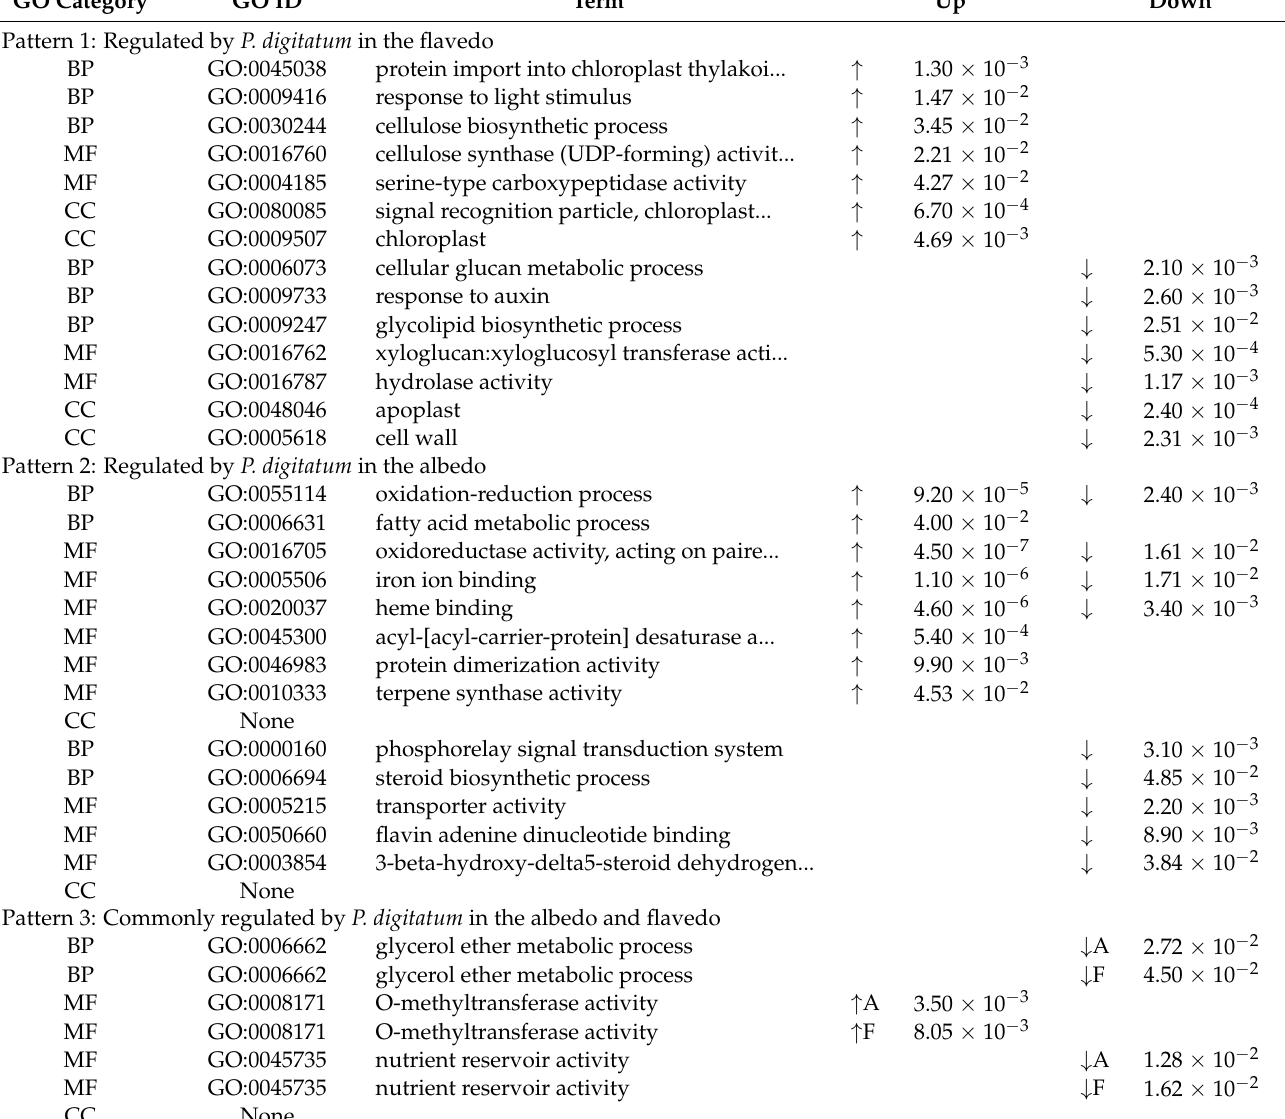
Table 2. Gene ontology (GO) analysis ( p ≤ 0.05) of the biological (BP) and molecular function (MF) processes and of the cell components (CC) induced ( ↑ ) or repressed ( ↓ ) in flavedo (F) and/or albedo (A) by 1 d post-inoculation (1 dpi) of the Navelate fruit inoculated with 10 µ L of a 10 4 conidia mL − 1 suspension of P. digitatum spores in relation to their wounded (control) samples. Three biological replicates from each condition were used. Only the DEGs ( p ≤ 0.05) showing at least a 2-fold change in expression were included in the